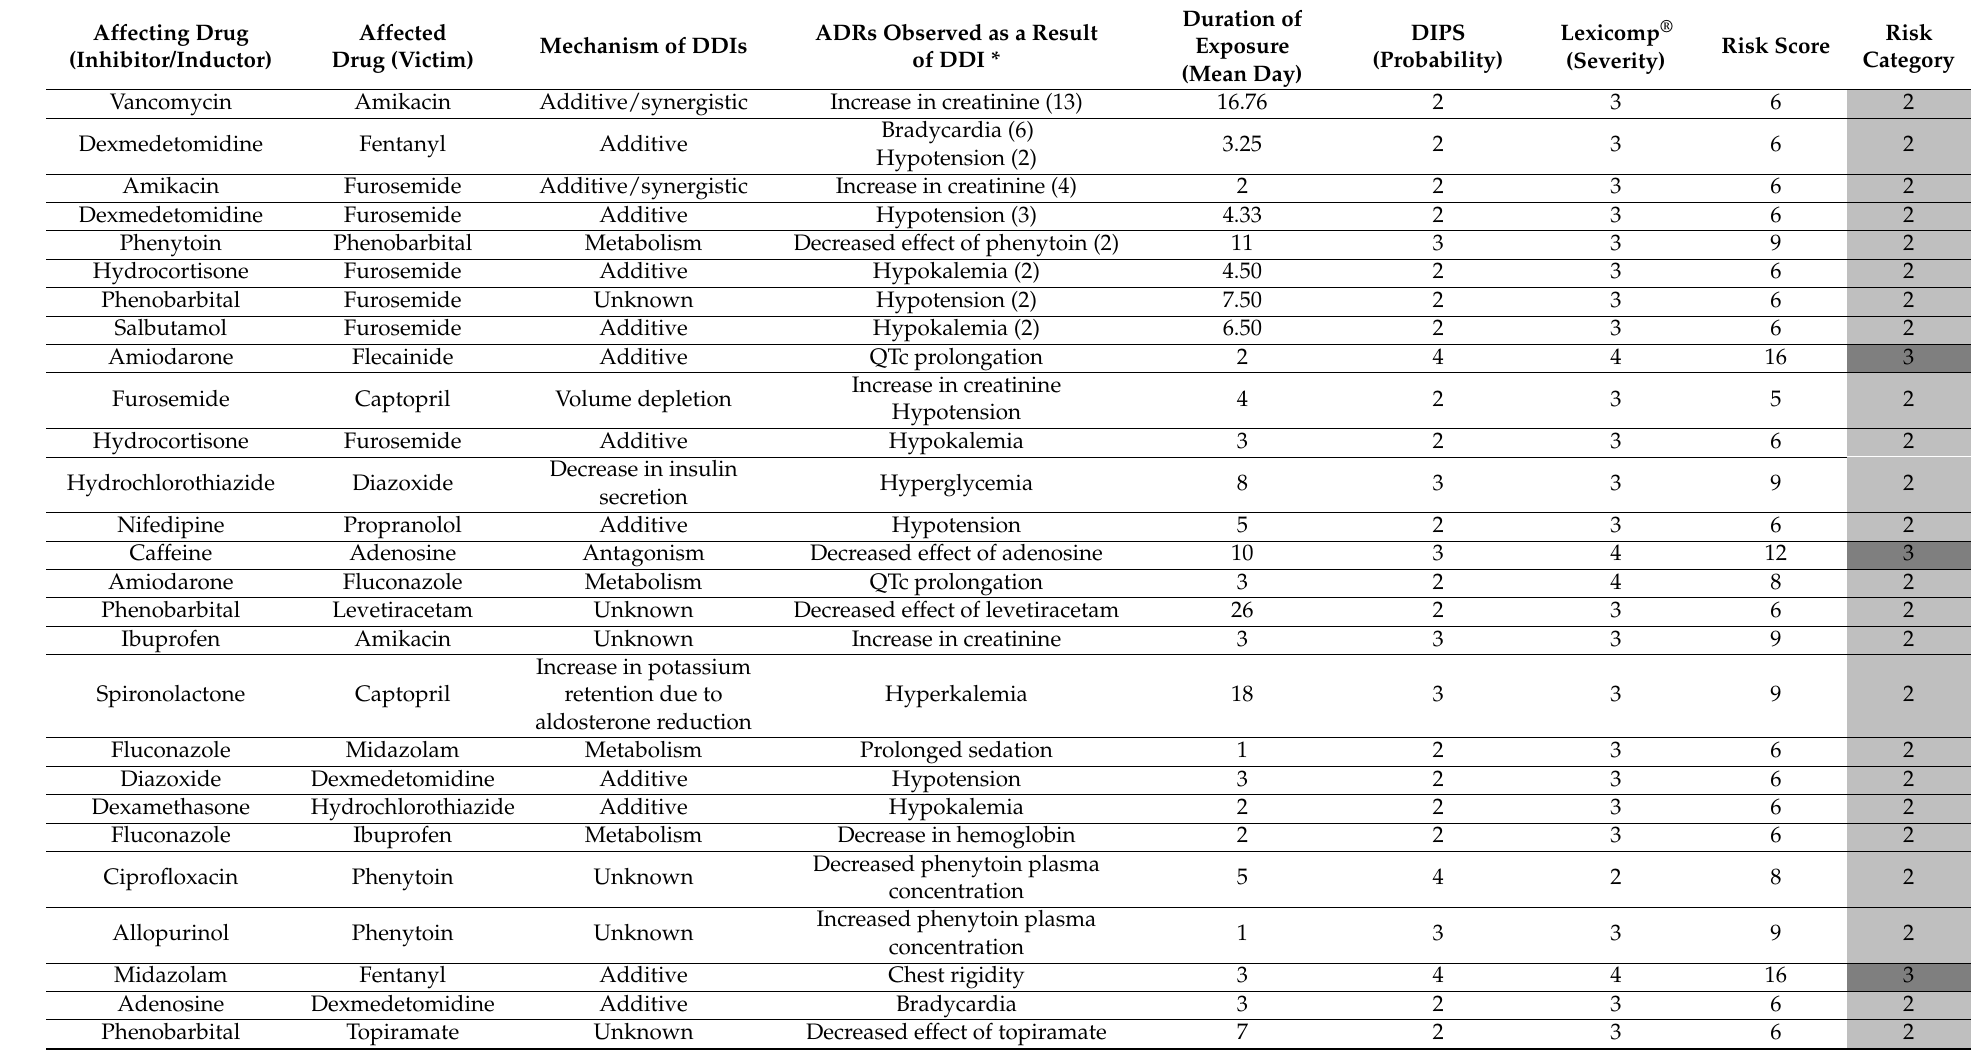
Table 2. The type, outcome, duration of exposure, probability, severity, and risk category of clinically relevant DDIs observed in the study (n =